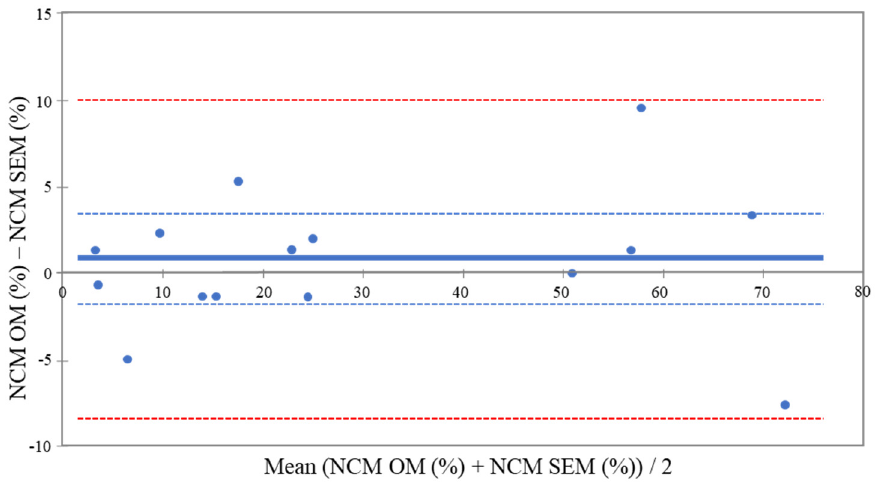
Figure 4. Bland and Altman plot showing the concordance between marginal analysis of the two methods. The mean difference between the methods is plotted with the solid blue line against the averages of the two methods and represents the bias. The blue dotted lines are +/ − 95% confidence interval and the red dotted lines represent the limits of agreement. The majority of the observations are within the limits of agreement.